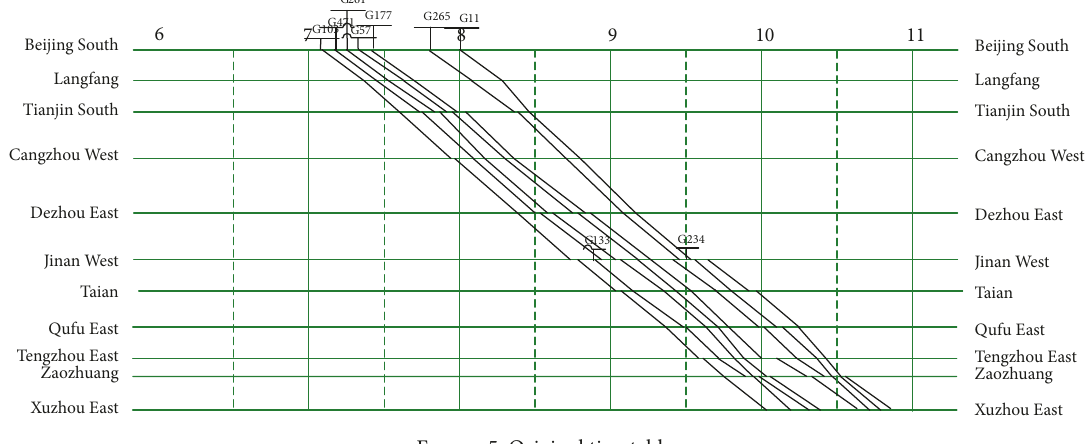
Figure 5: Original timetable.